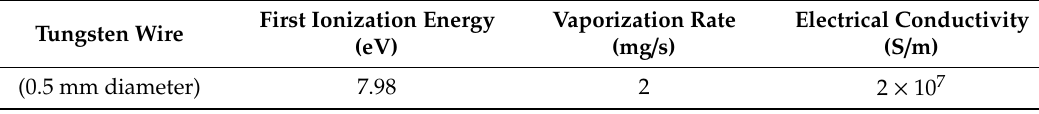
Table 1. Energetic parameters and vaporization rate of the tungsten.